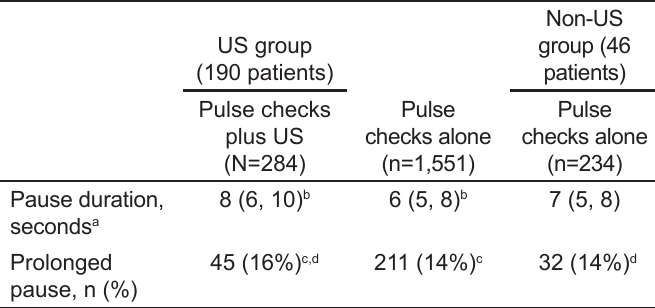
Table 5. Pause duration for pulse checks and the percentage of prolonged